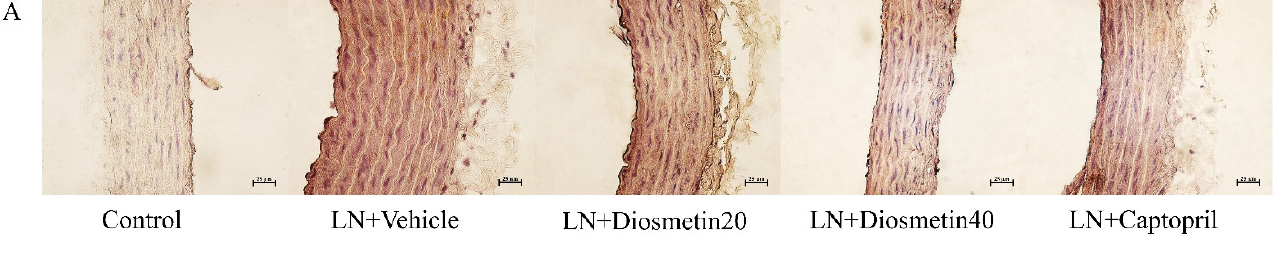
Figure 8. Effect of diosmetin and captopril on interleukin-6 (IL-6) immunohistochemical staining for vascular tissue ( A ) and IL-6 level ( B ) in LN-induced hypertensive rats. a p < 0.05 vs. control group, b p < 0.05 vs. LN + vehicle group. LN, L- NAME; LN + diosmetin20, L-NAME treated with 20 mg/kg of diosmetin; LN + diosmetin40, L-NAME treated with 40 mg/kg of diosmetin; LN + captopril, L-NAME treated with captopril ( n = 7–8/group). Statistical analysis between the five groups was performed using the one-way ANOVA followed by Turkey’s post hoc test. 3.8. Effect of Diosmetin and Captopril on Vascular p-JNK/p-NF- κ B Protein Expression Upregulation of the p-JNK/p-NF- κ B protein expression in vascular tissue was detected in the LN rats ( p < 0.05). Administration of diosmetin and captopril decreased the overexpression of the p-JNK/p-NF- κ B proteins in the L-NAME-induced hypertensive rats ( p < 0.05) (Figure 9A,B).